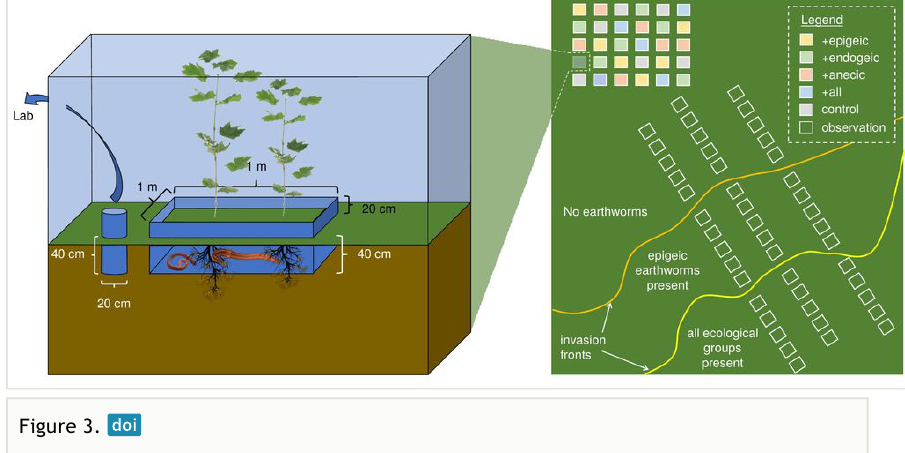
Figure 3. Experimental design. (Right panel) One forest patch (four spatially independent patches in total) with invasion fronts of epigeic earthworms (orange) and endogeic and anecic earthworms (yellow) present. Three transects à 15 observation plots (1 x 1 m; Eisenhauer et al. 2007) will be established. In the area without earthworms, a fi eld experiment will be set up with experimental plots (Left panel), fi ve treatments, and six replicates. PVC shields will be used to establish earthworm enclosures of 1 x 1 m (Eisenhauer et al. 2009b). Phytometers will